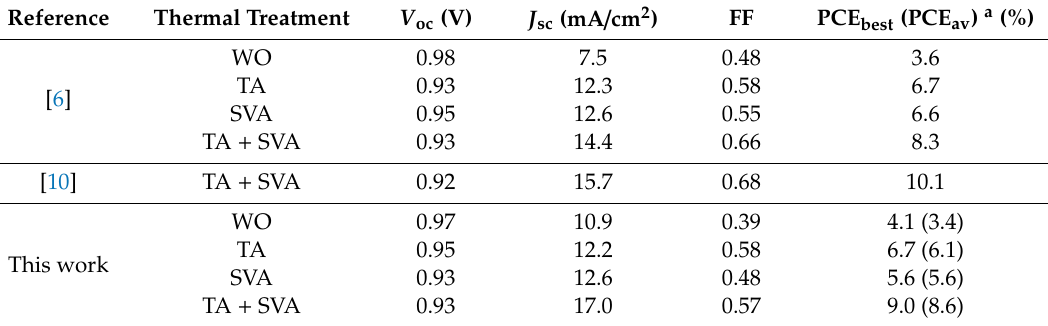
Table 2. Comparison of the best PV parameters for DRCN5T:[70]PCBM BHJ based OSCs.